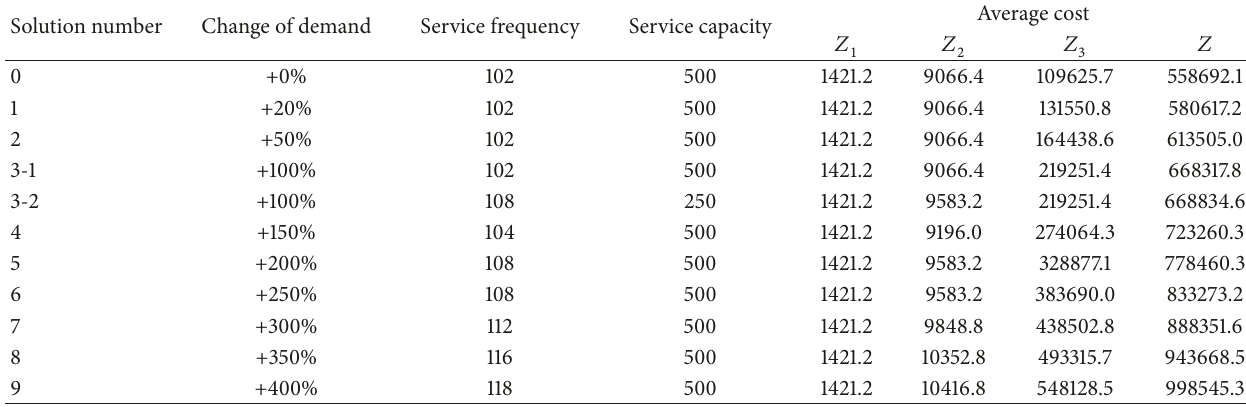
Table 9: The impact of demand 𝑄 𝑚 on the HPTB-EPS